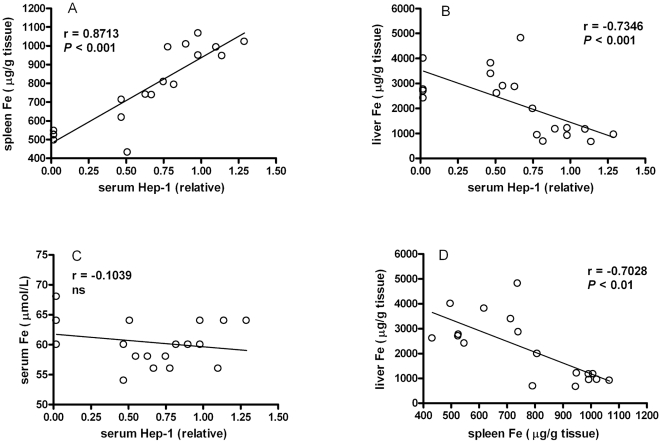
Correlations between serum Hep-1 and liver hepcidin-1 mRNA, and iron concentrations of serum, spleen and liver.Data are obtained from wild type mice (n = 8), Hfe knockout mice (n = 3), TfR2 Y245X mice and double affected Hfe/TfR2 Y245X mice (n = 4). Correlation was tested by Spearman. ns, not significantly different.